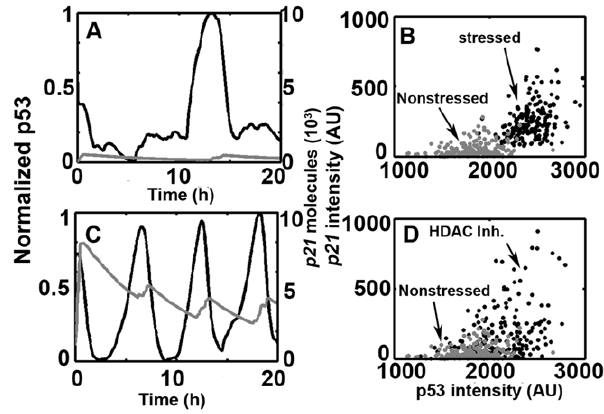
Figure 8. P53 and p21 dynamics under stressed and non- stressed conditions. (A and C) p21 (grey) and normalized p53 pulses (black). (B and D) Scatter plots of p53 and p21 integrated responses. (B) Stressed (black) versus nonstressed (grey) conditions. (D) HDAC (black) versus nonstressed (grey) conditions, HDAC: histone deacetylase.